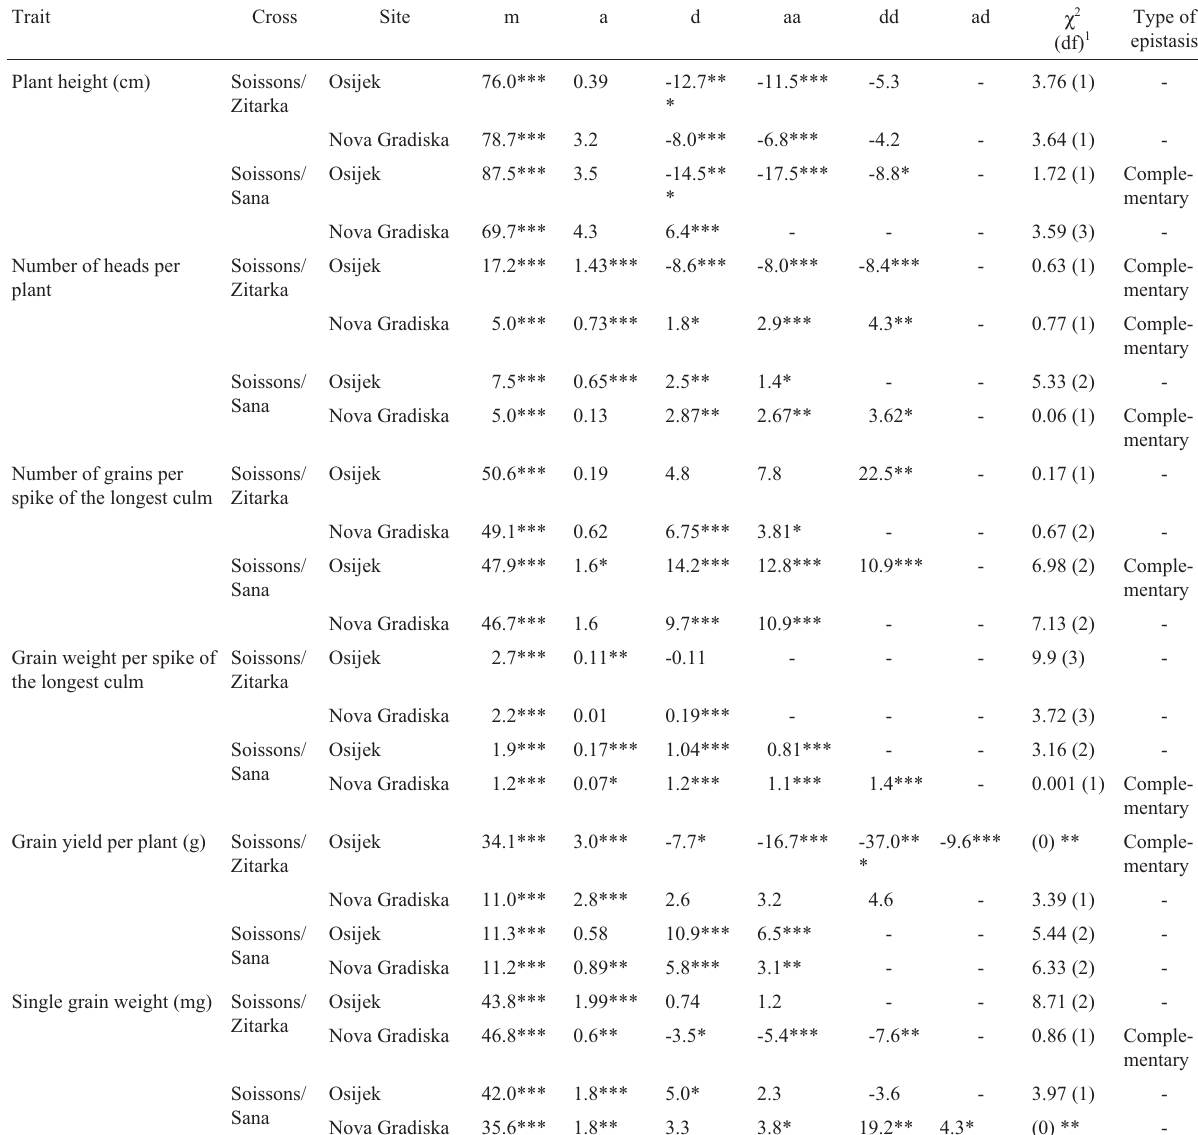
Table 3 - The estimates of gene effects for six quantitative traits in two crossing combinations and sites.